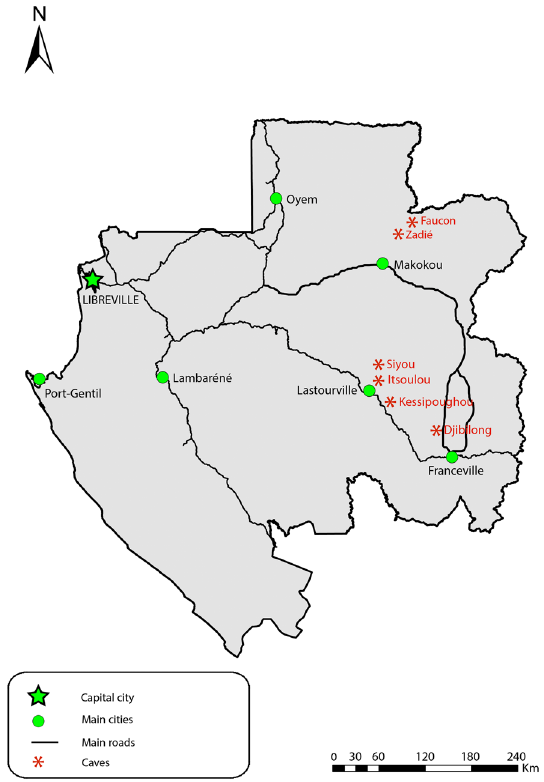
Figure 1. Geographic location of the six investigated caves. The map was created by co-authors using ArcGis 10.04.01